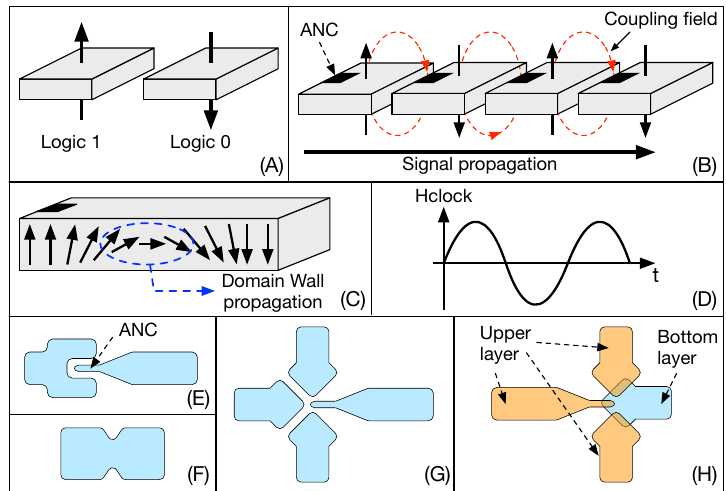
Figure 20. pNML basics. ( A ) The magnetization direction encodes logic ‘0’ and ‘1’. ( B ) The Artificial Nucleation Center (ANC) guarantees correct signal propagation in a perpendicular Nano Magnetic Logic (pNML) chain of magnets. ( C ) Domain wall propagation inside the nanomagnet causes the switch of the magnetization direction. ( D ) Global out-of-plane magnetic field used as clocking mechanism. ( E ) Inverter. ( F ) Notch. ( G ) Minority voter. ( H ) 3D minority voter.